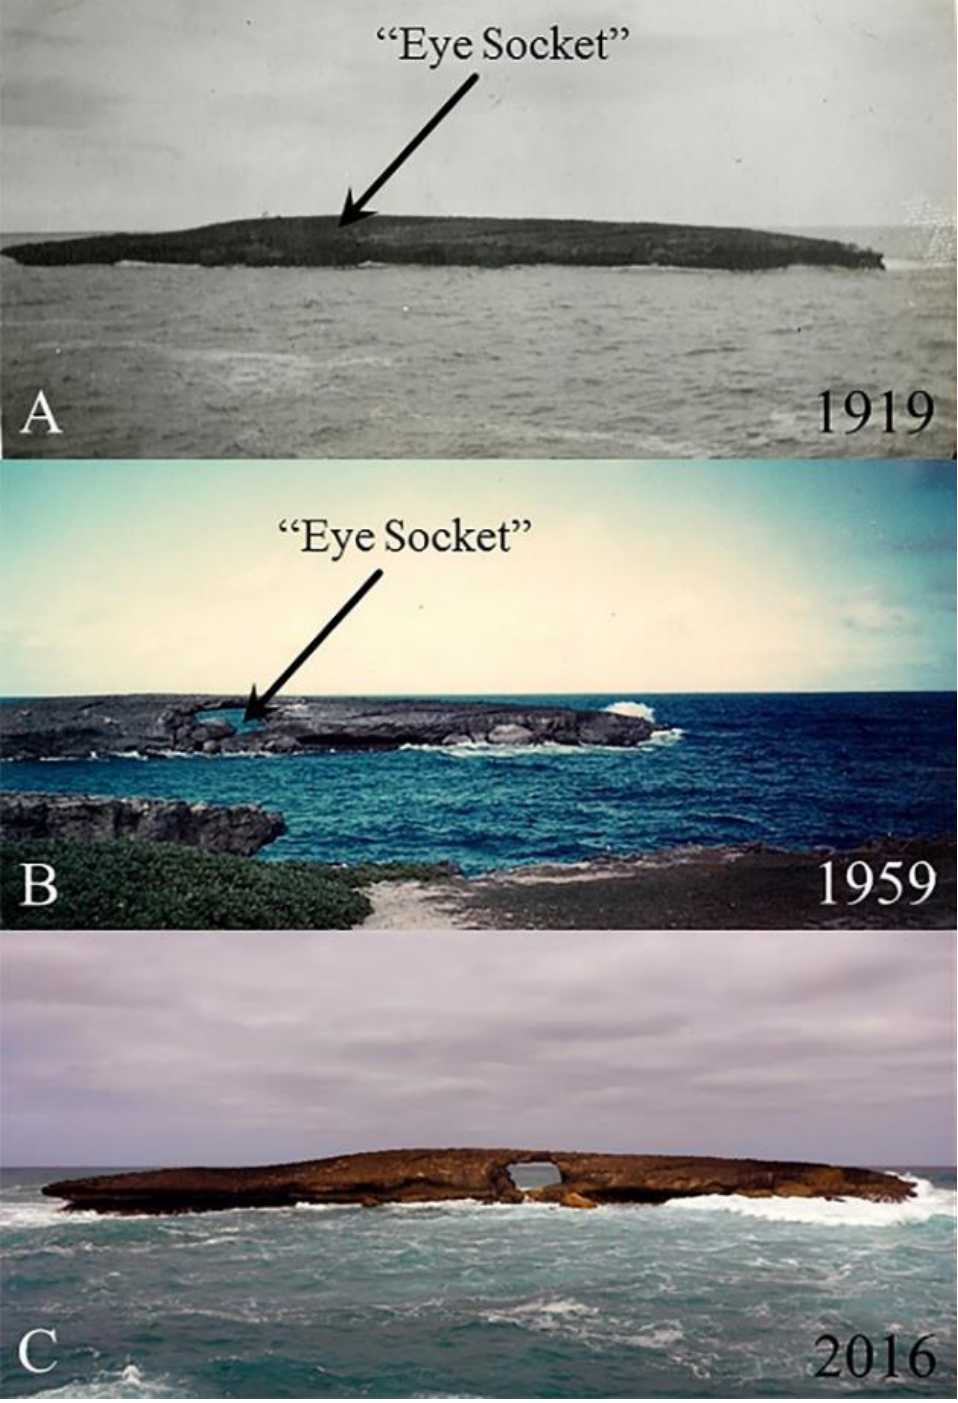
Figure 8. Historical images showing Kukuio’olua Island both before ( A ) and after ( B ) the formation of its modern sea arch. Formation of the arch occurred sometime between 1919 and 1959. The bottom image ( C ), shows the arch after its more recent change.